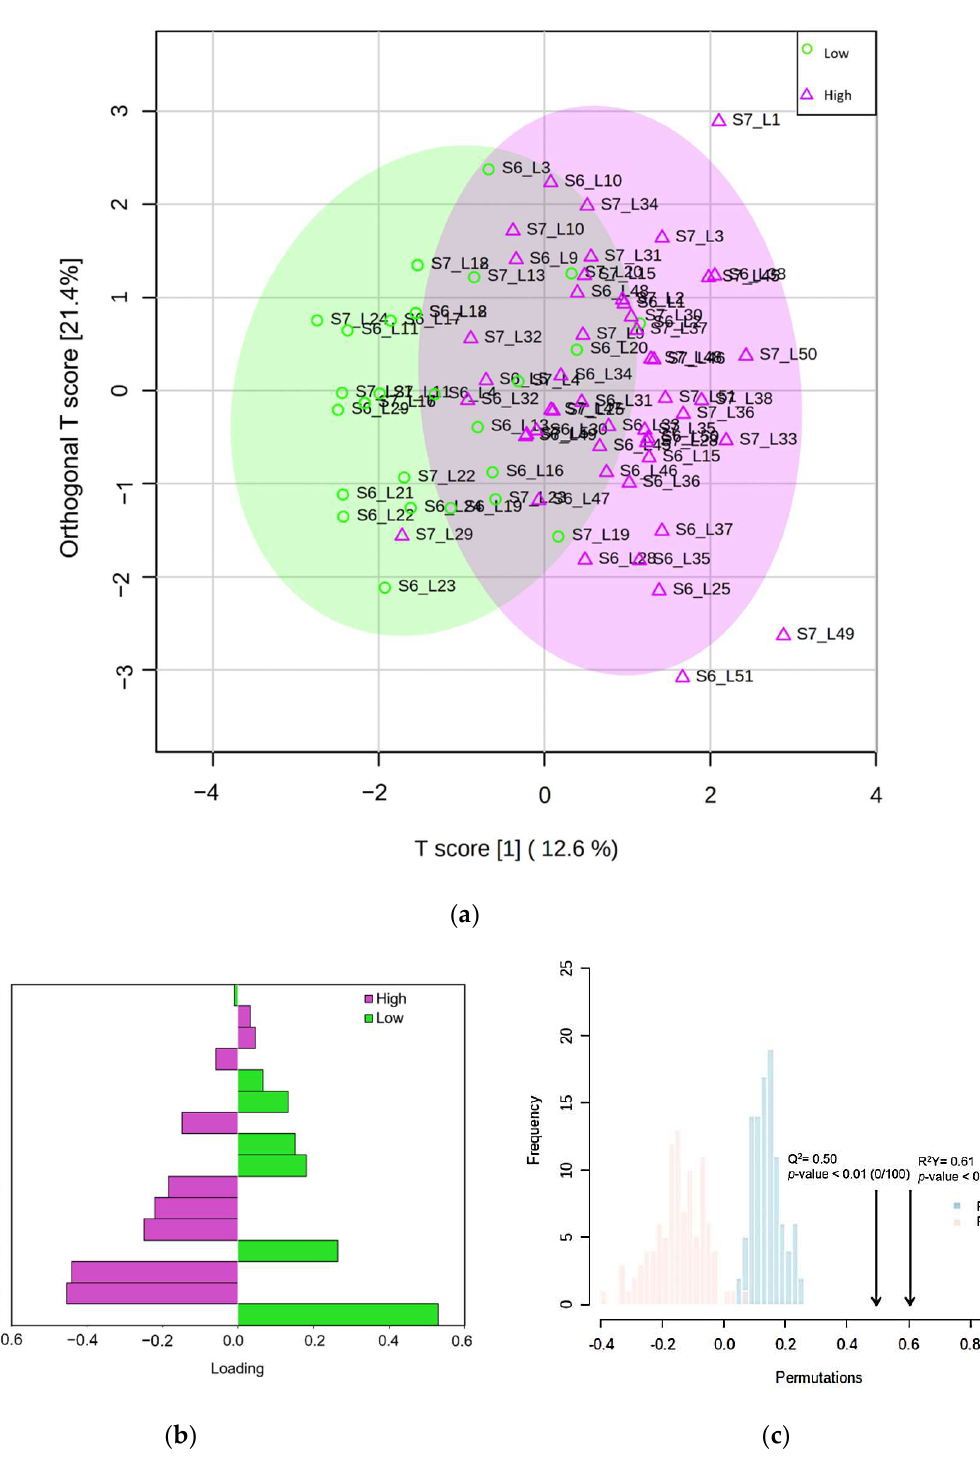
Figure 5. ( a ) OPLS-DA score plot of all soil variables, based separation of the incidence (low incidence of BW, n = 29; high incidence of BW, n = 49); ( b ) Loading plot weights of each variable selected from OPLS-DA; The color indicates the class in which the variable has the maximum level of expression; ( c ) internal validation of the corresponding OPLS-DA model by permutation analysis ( n = 100); fraction of the variance of descriptor class response (Y) (R 2 Y) = 0.61 (blue bars), p value < 0.01; fraction of the variance predicted (cross-validated) (Q 2 ) = 0.50 (red bars), p value < 0.01.